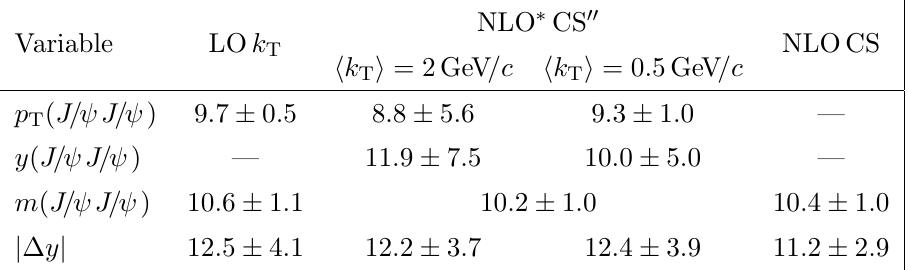
Table 4 . Summary of the (cid:27) e(cid:11) values (in mb) from DPS (cid:12)ts for di(cid:11)erent SPS models. The uncertainty is statistical only, originating from the statistical uncertainty in (cid:27) DPS (and d (cid:27) ( J= J= ) = d v ). The common systematic uncertainty of 12%, accounting for the systematic un- certainty of (cid:27) ( J= J= ) and the total uncertainty for (cid:27) ( J= ), is not shown.